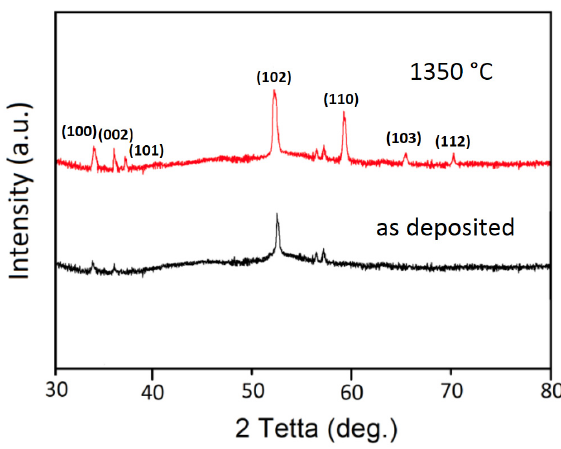
Figure 5. XRD spectra for as-deposited and annealed samples.